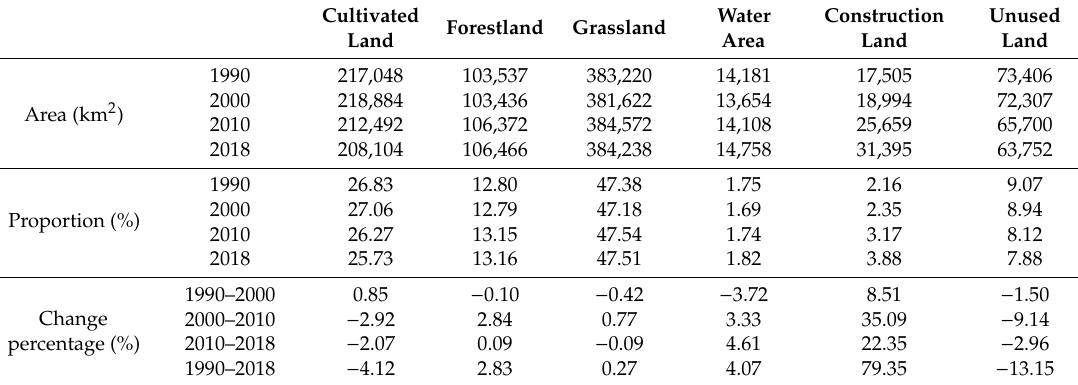
Table 2. Land use change in the YRB from 1990 to